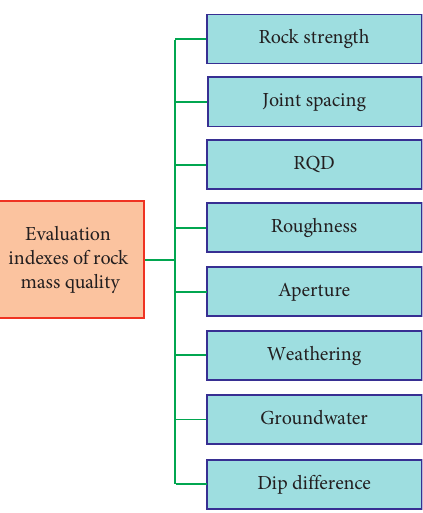
Figure 8: The hierarchical structural model of rock mass classification. Table 5: The fundamental scale of AHP (Saaty